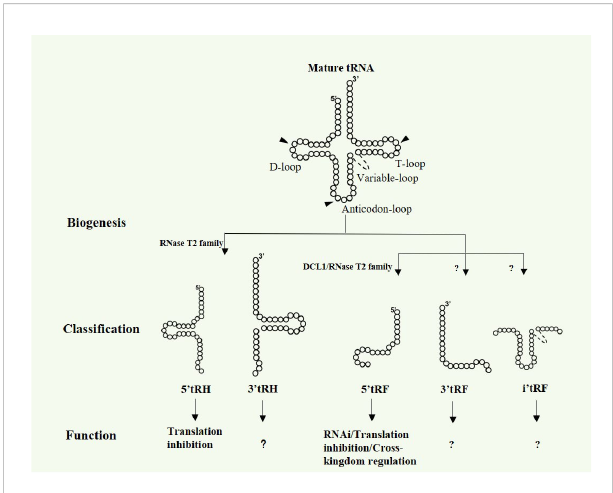
FIGURE 1 Biogenesis, classi fi cation and function of tsRNAs in plants. Arrow heads show the cleavage sites in mature tRNAs, generating 5 types of